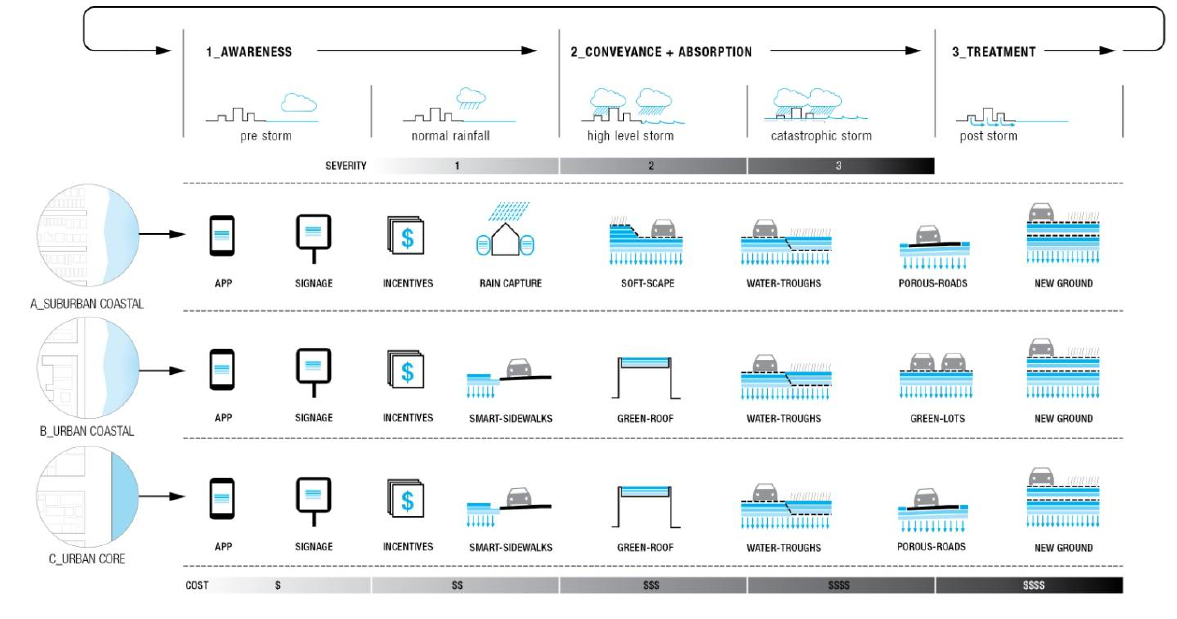
Figure 3. PoroCity Adaptation